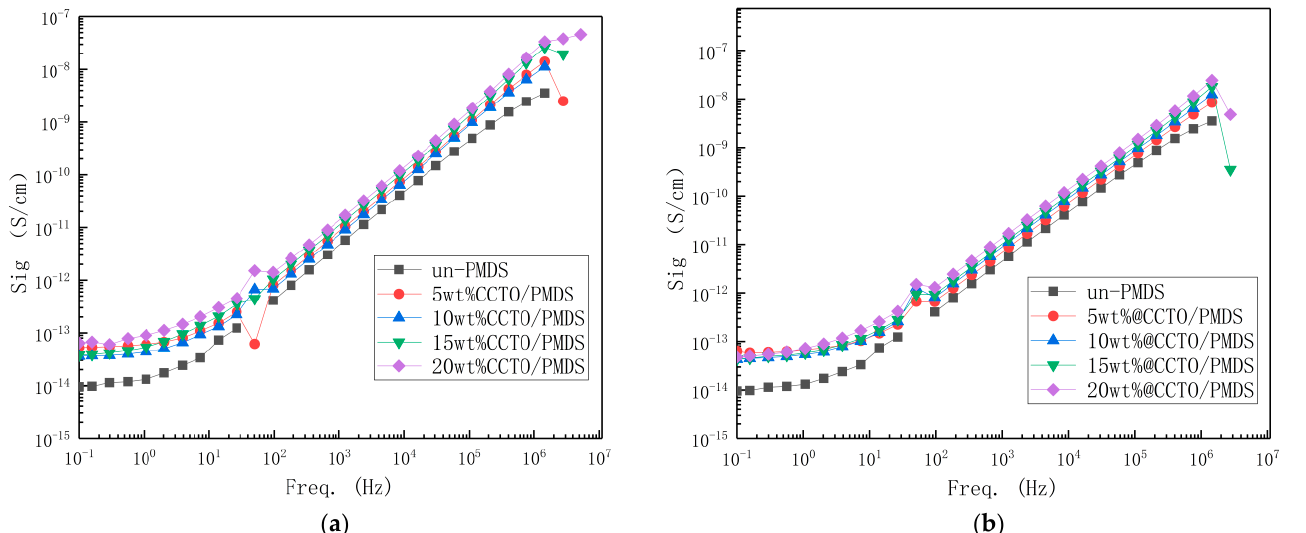
Figure 13. ( a ) Conductivity of CCTO/PDMS composites at different frequencies; ( b ) Conductivity of @CCTO/PDMS composites at different frequencies.